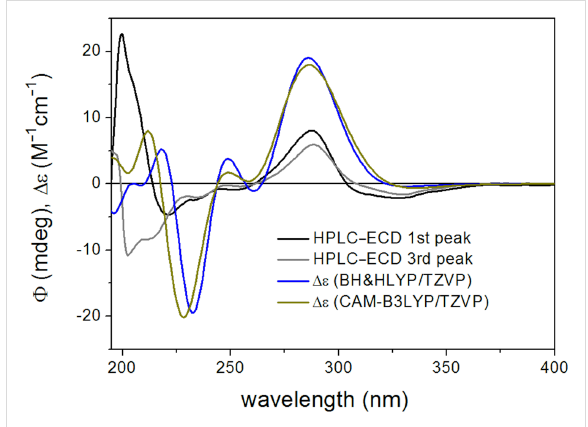
Figure 12: Experimental HPLC-ECD spectra of 3b (first eluted stereo- isomer) and 3c (third eluted stereoisomer) compared with the Boltz- mann-weighted ECD spectra computed for the CAM-B3LYP/TZVP PCM/MeCN low-energy conformers of (2 R ,5’’ R )- 3 at various